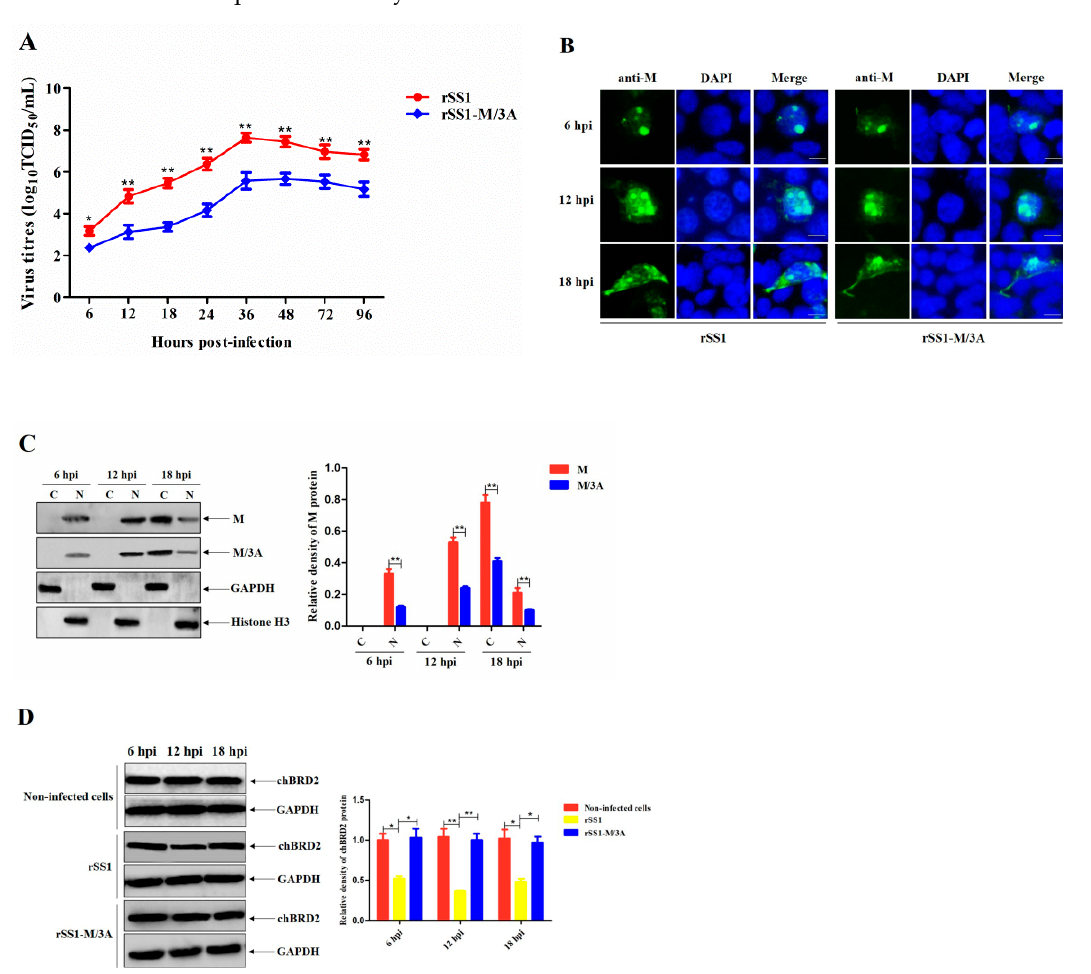
Figure 5. The M/3A protein leads to decreased replication ability of recombinant NDV. ( A ) The multicycle growth kinetics of rSS1 and rSS1-M/3A were determined in cells at different time points. ( B ) The subcellular localization of M and M/3A proteins in virus-infected cells was examined by IFA. DAPI (blue) counterstained the nuclei. The original magnification was 1 × 100. Scale bars